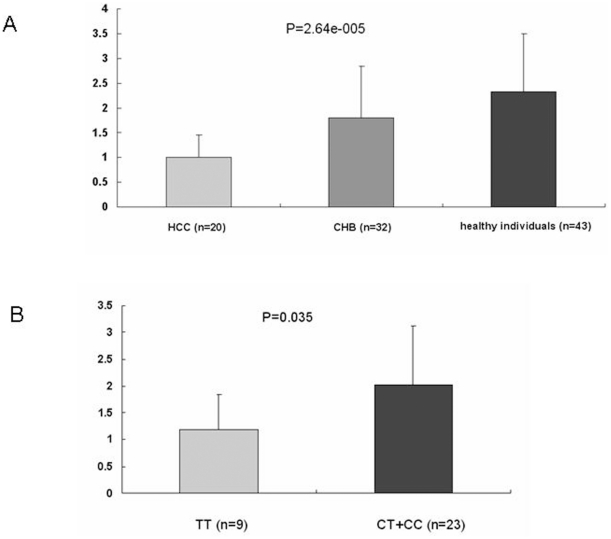
Quantification of COL18A1 mRNA expression by real-time PCR.GAPDH was used as an internal control gene. Final abundance figures were adjusted to yield an arbitrary value of 1 for HCC patients. Each experiment was performed in triplicate assay. Data are means±SD. A. COL18A1 mRNA expression in HCC, CHB, and healthy individuals. B. COL18A1 mRNA expression in CHB patients, among different genotypes of rs7499.